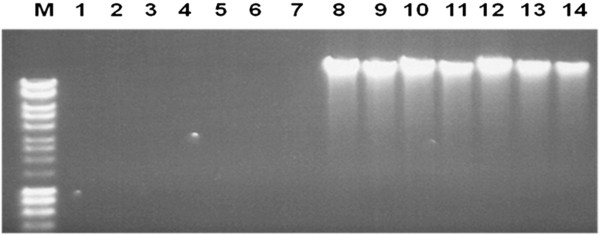
DNA preparations made by STEM1 and the conventional method. M: DNA marker; 1–7: DNA prepared by the STEM1; 8–14: DNA prepared by the conventional method. Lanes 1 and 8, 2 and 9, 3 and 10, 4 and 11, 5 and 12, 6 and 13, 7 and 14: DNA prepared from the spiked blood samples containing 3x105, 3x104, 3x103, 3x102, 30 , 3, 0 CFU/ml of Salmonella Typhi, respectively.